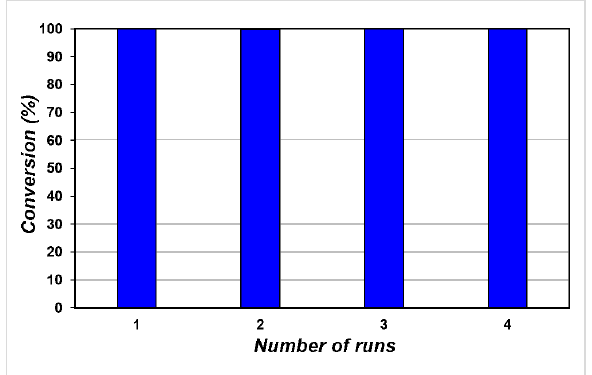
Figure 4: The reusability of the catalyst NU-400 MOF over four successive injections of CEES (0.2 mmol) into the same reaction vial.